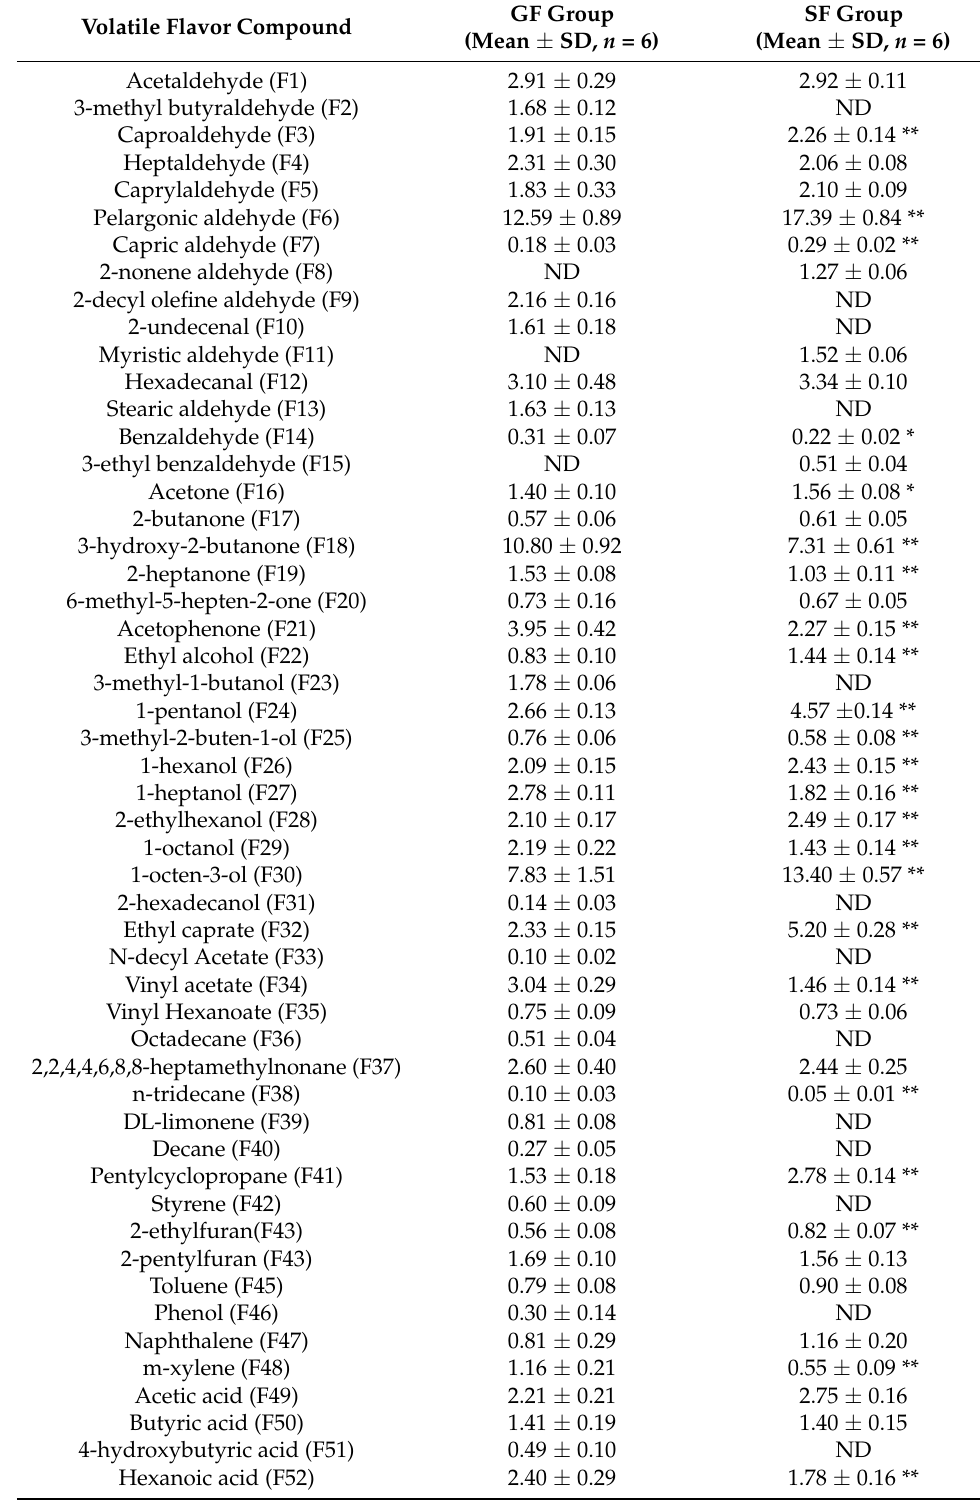
Table 3. The relative content of volatile flavor compounds in the yak LD under SF and